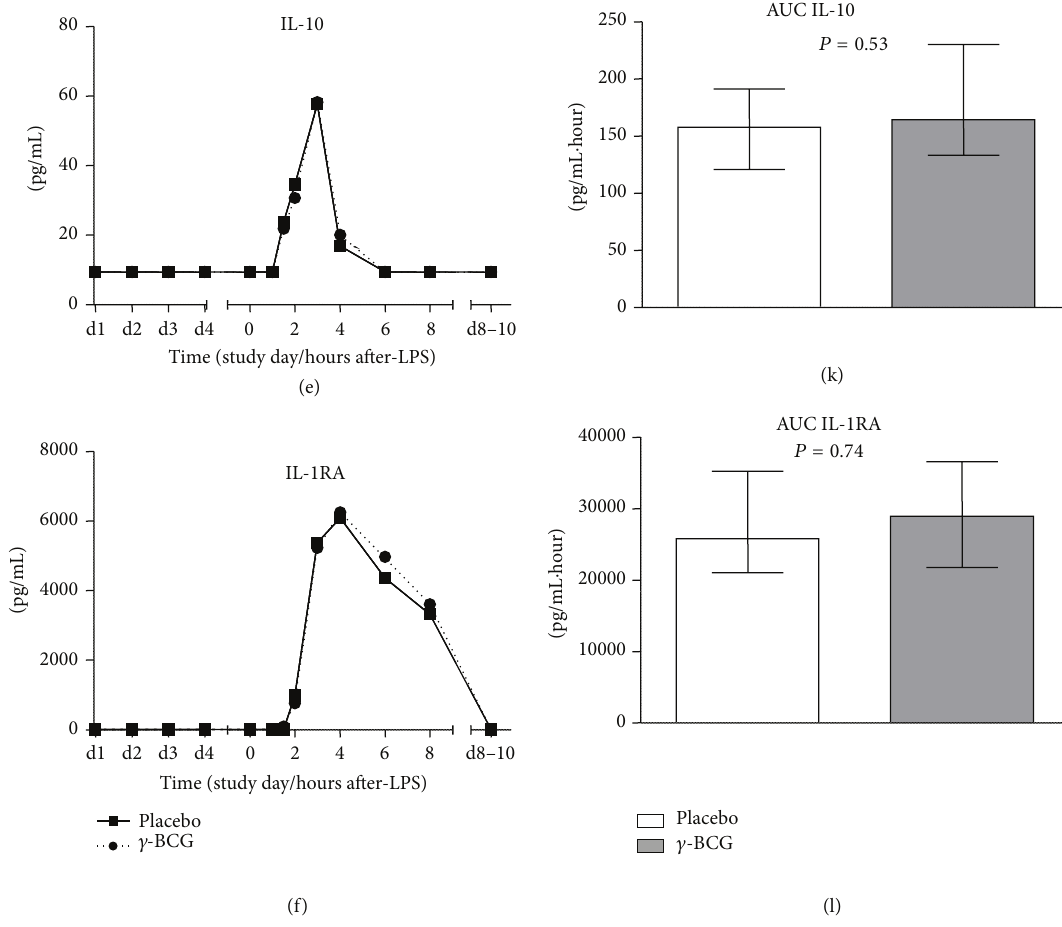
Figure 3: Plasma cytokine concentrations in subjects vaccinated with gamma-irradiated BCG or placebo. In the panels (a–d), median values of proinflammatory cytokines TNF- 𝛼 , IL-6, IL-8, and MCP-1 are depicted while in panels (e) and (f) median values of anti-inflammatory cytokines IL-10 and IL-1RA are shown ( 𝑛 = 10 per group). Panels (g–l) depict median ± interquartile range of area under curve (AUC) of the respective cytokines ( 𝑛 = 10 per group). 𝑃 values calculated using Mann-Whitney 𝑈